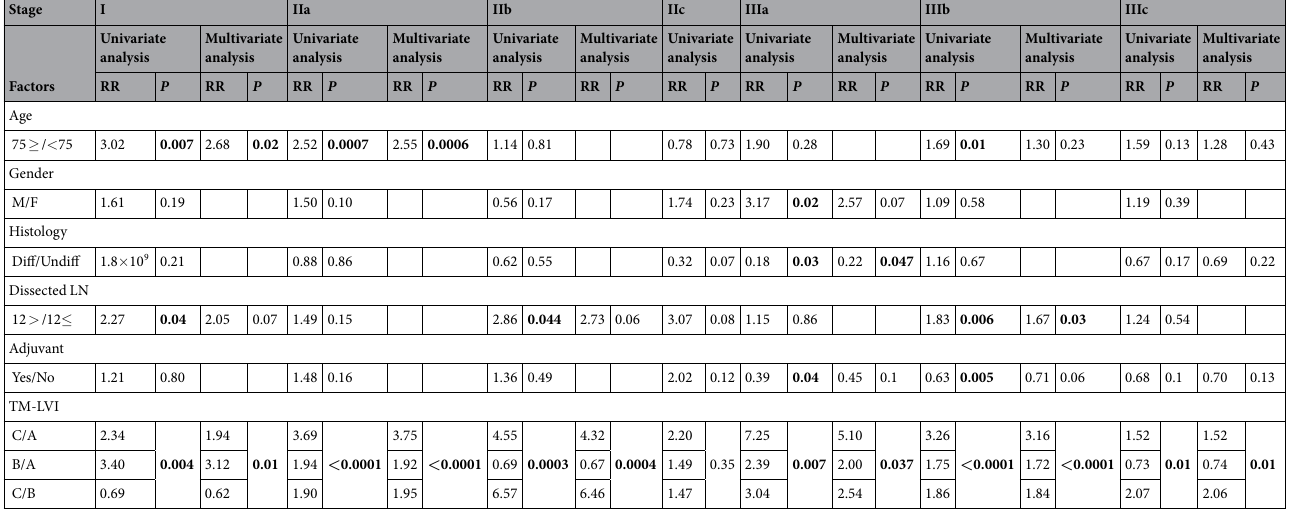
Table 5. Univariate and multivariate analysis for disease specific survival of rectal cancer was performed in each clinical stage. TM-LVI was an independent prognostic factor for relapse-free survival of rectal cancer in stage I, IIa, IIb, IIIa, IIIb, and IIIc. M/F, Male/Female; Diff/Undiff, Differentiated/Undifferentiated; LN, Lymph node; RR, Risk ratio; Bold type, P <